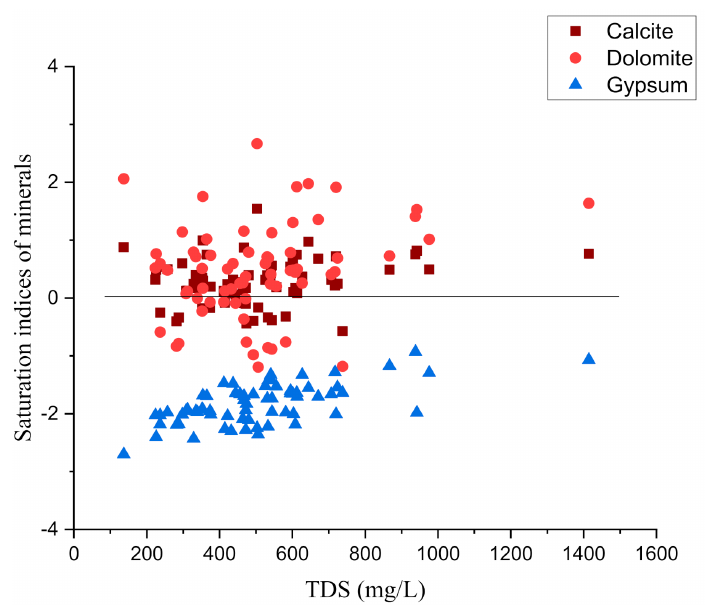
Figure 6. The variation of saturation indices of the selected